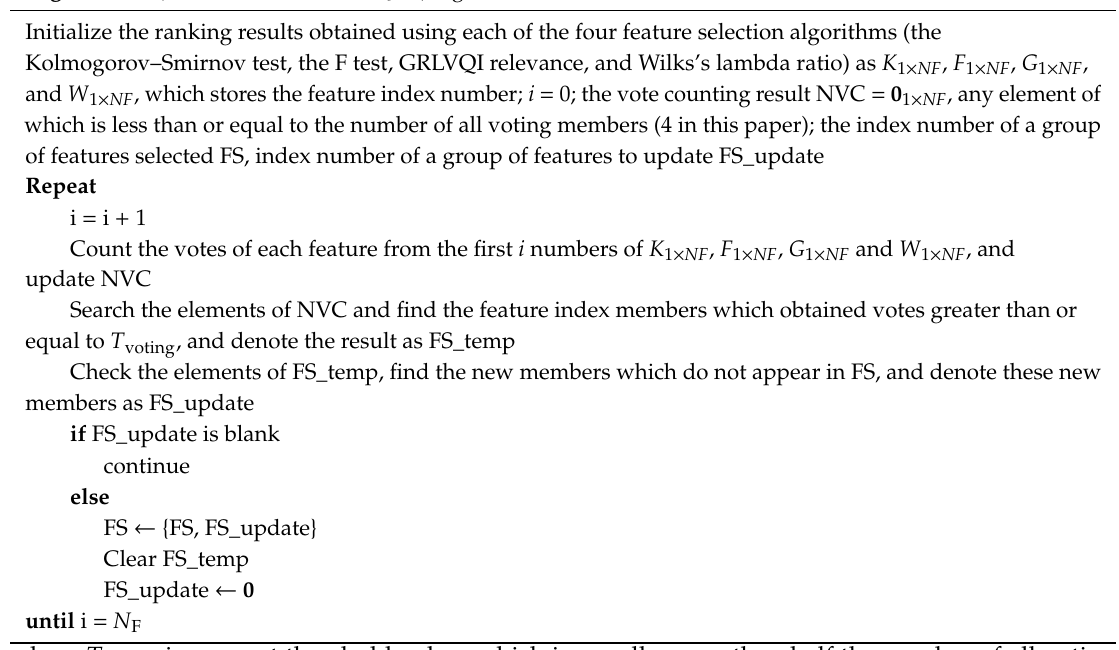
Algorithm 1: Joint feature selection (JFS)